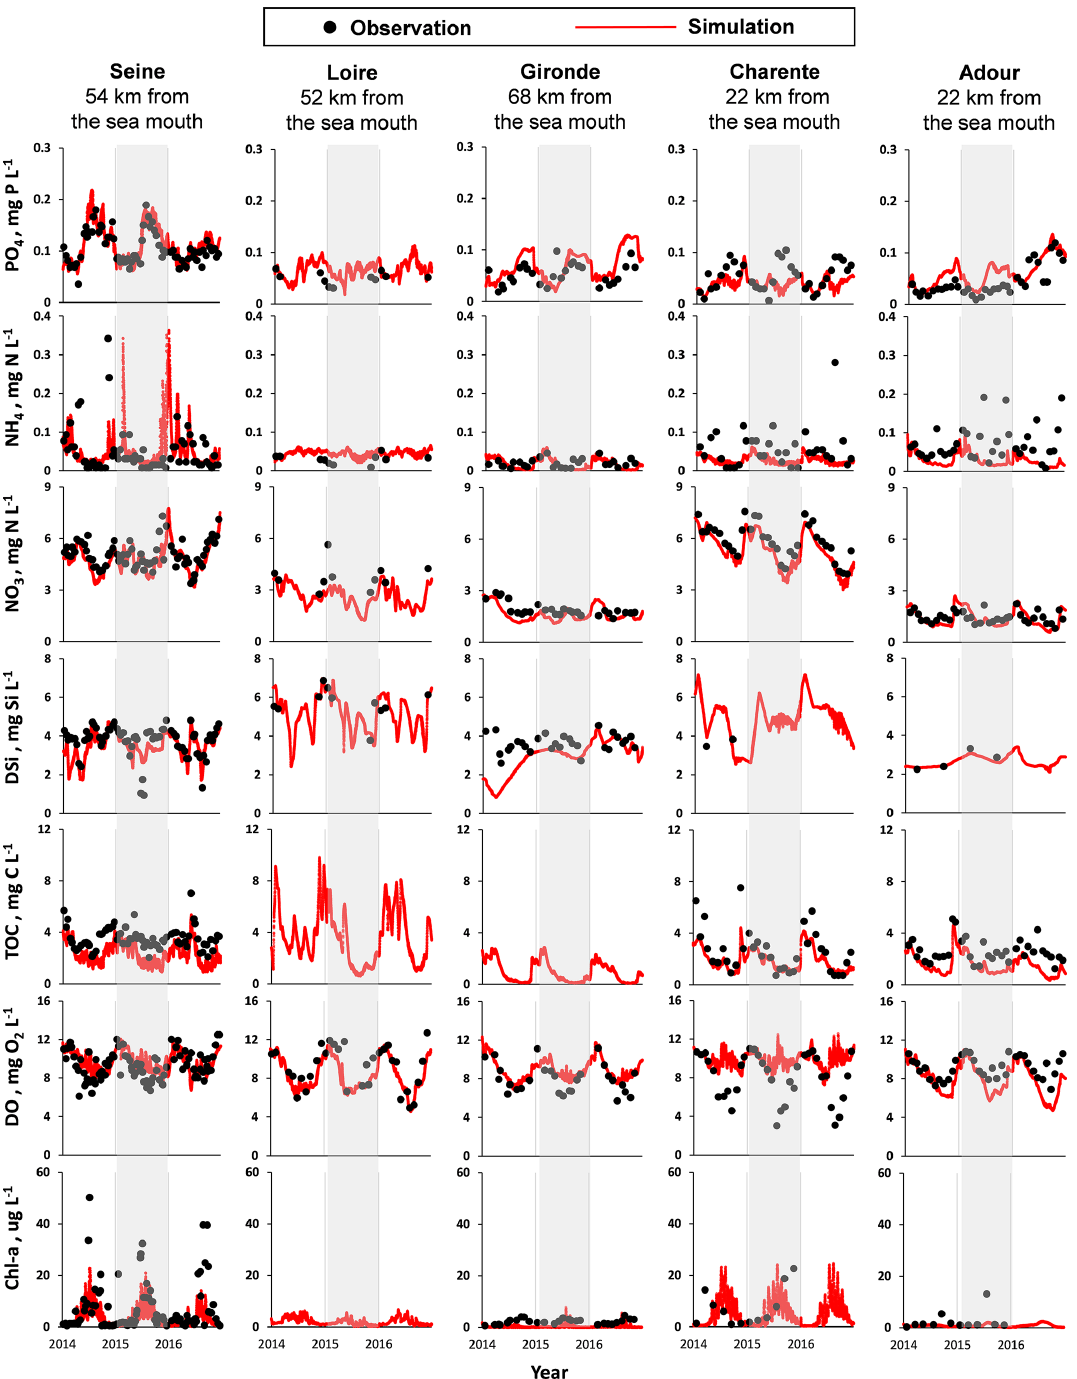
Figure 4. Temporal variations for salinity (Sal), phosphate (PO 4 ), ammonium (NH 4 ), nitrate (NO 3 ), dissolved silica (DSi), total organic carbon (TOC), dissolved oxygen (DO), and chlorophyll a (Chl a ) concentrations from 2014 to 2016 for the Seine, Loire, Gironde, Charente, and Adour estuaries at the sampling stations located about one-third of the length of the estuary to the sea mouth. Gray columns covered the year of calibration (2015). The results of the Somme and Vilaine are shown in the Supplement.